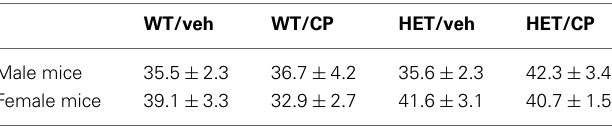
Table 2 | Total number of arm entries in the Y-maze after a 2-h retention period.